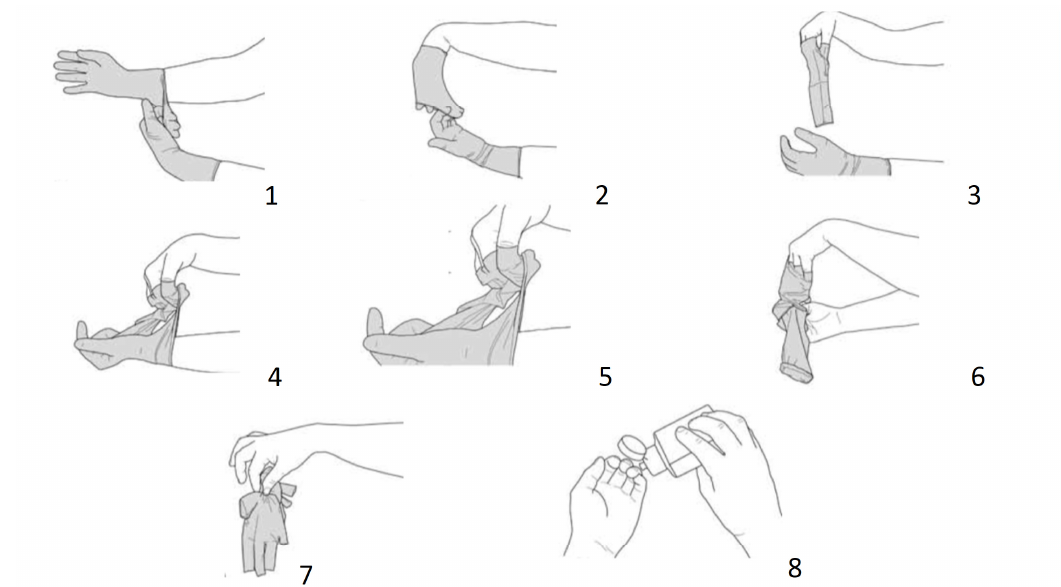
Figure 6. How to remove gloves.